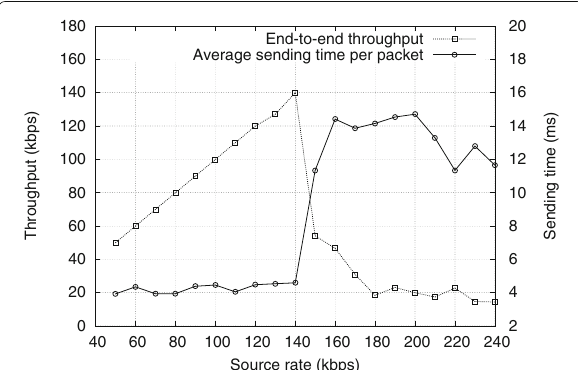
Fig. 6 End-to-end throughput and the sending time per data packet in MAC at the